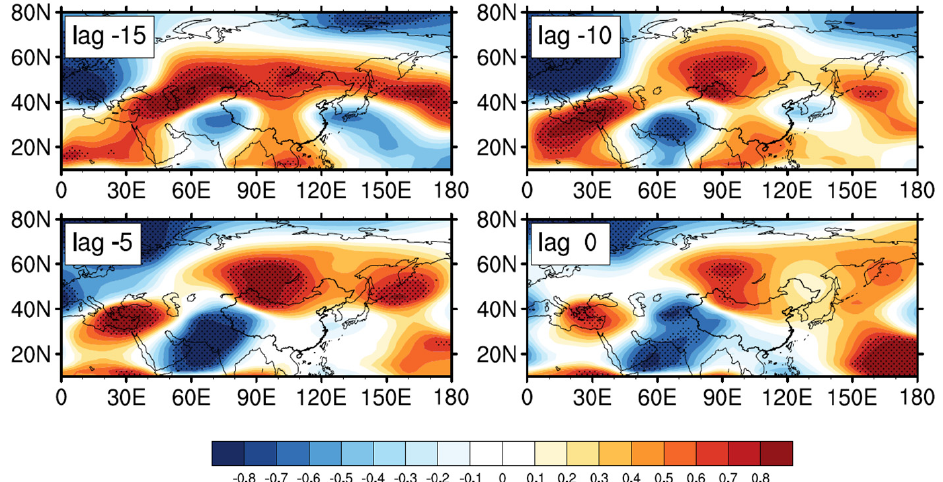
Figure 11. RMM index and the fifth-phase 200-hPa height field lead correlation. (Lag-n denotes leading of phase 5 of the 30–60-d filter for n days. Dotted areas indicate correlations passing the 95% significance test).